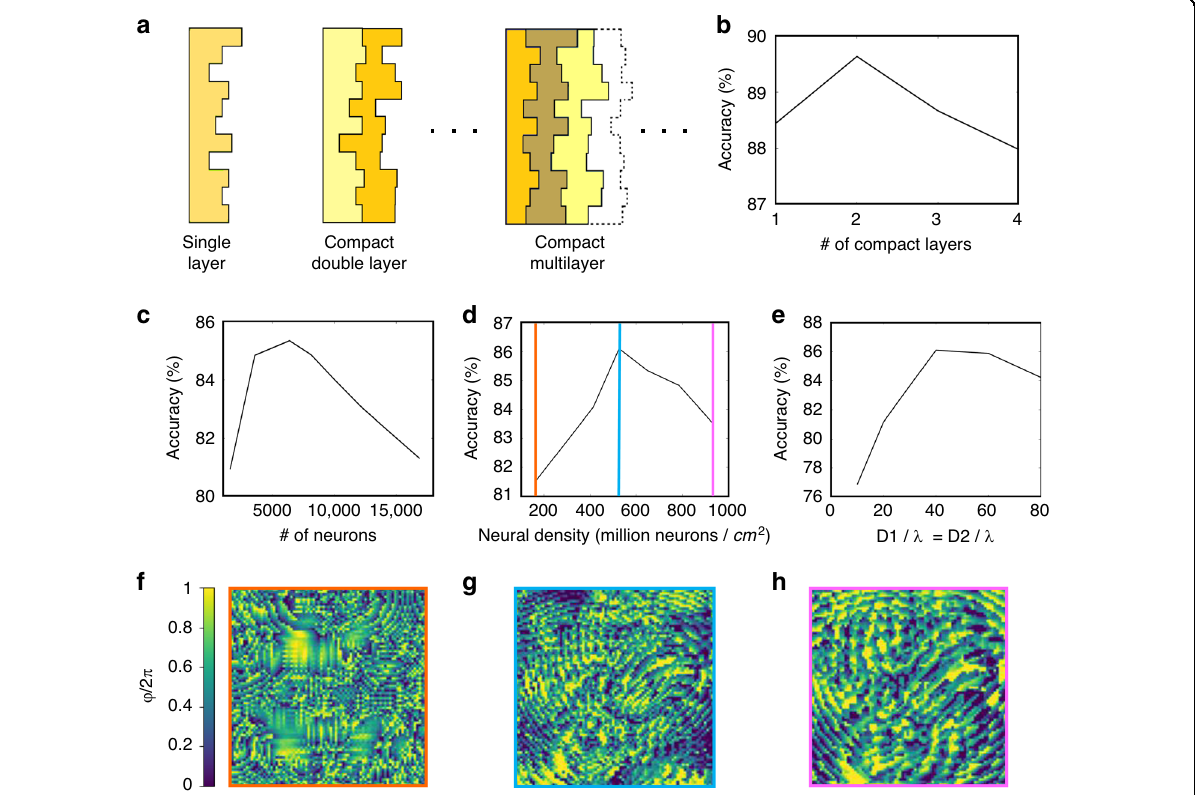
Fig. 2 Neuron density effect on the MLD optical inference ability. a Schematic of MLD designs consisting of one, two and multiple compact layers. b Blind test classi fi cation accuracy of the 9-MLD as a function of the number of compact layers. The pixel diameter is 419 nm, and the distances from the input plane to the compact layers and from the compact layer to the output plane are 70.7 and 31.4 μ m, respectively. Classi fi cation accuracy achieved by the 9-MLD as a function of the number of neurons ( c ), neuron density ( d ), and distance from the input plane to the MLD (D1) and from the MLD to the output plane (D2) ( e ). f – h Calculated phase delay in the diffractive layer with the neuron density values as indicated by the coloured markers in d , showing the effect of the neuron density on the MLD